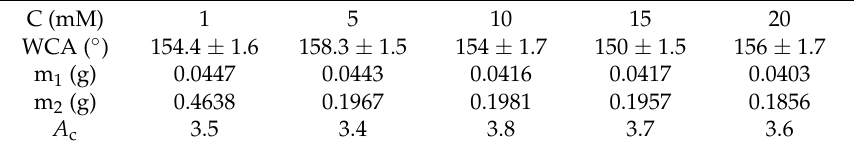
Table 1. The concentration optimization of ODE for the WCA and absorbing amount of engine oil. C